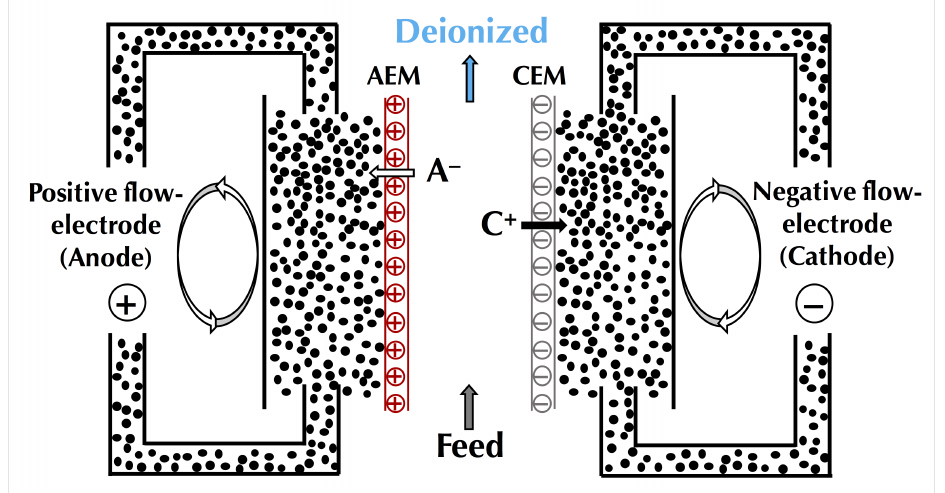
Figure 19. Principle of flow-electrode capacitive deionization. CEM: cation-exchange membrane; AEM: anion-exchange membrane; A − : anions; C + :